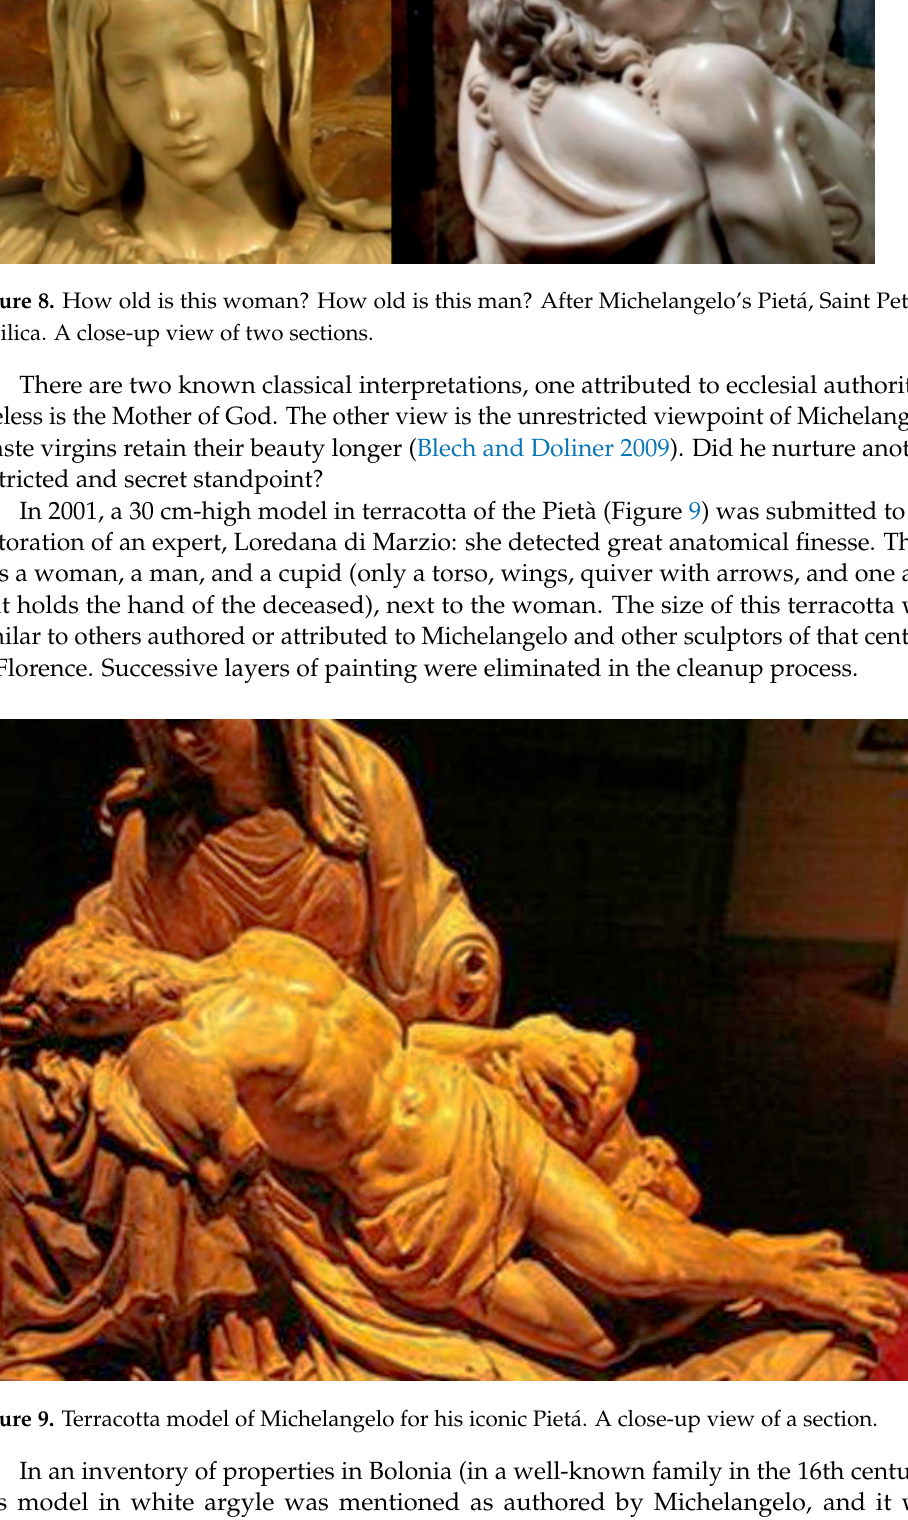
Figure 9. Terracotta model of Michelangelo for his iconic Pietá. A close-up view of a section.